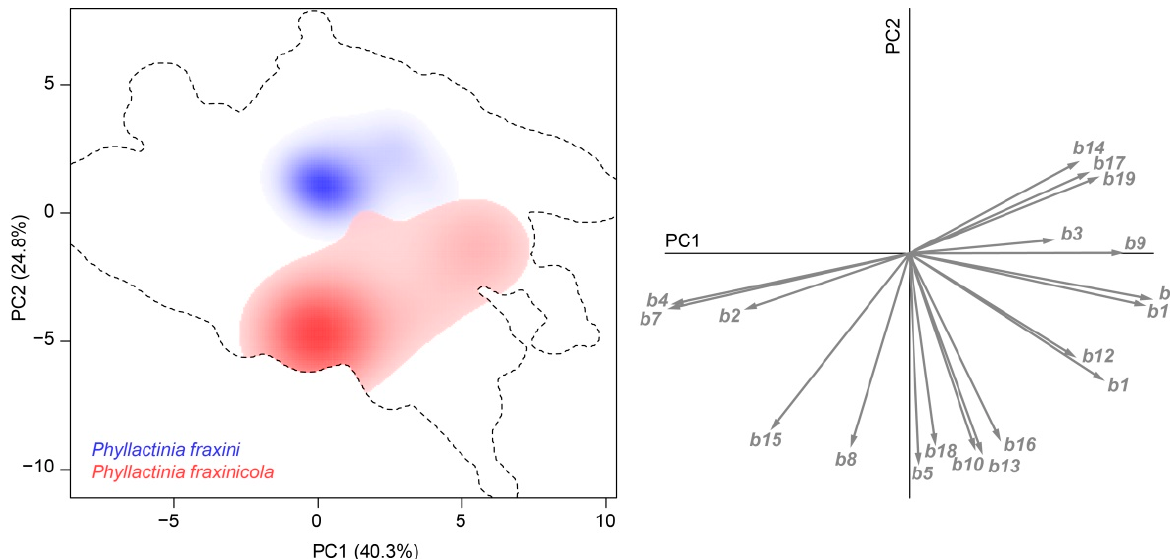
Figure 4. Differences in P. fraxini (blue) and P. fraxinicola (red) environmental niches in principal component space based on bioclimatic variables. Shading is proportional to the density of species occurrence. A dashed line indicates the available environmental space. Vectors of the bioclimatic variables show their contribution to the principal components. Variance explained by the components is given in parentheses. The variable abbreviations are explained in Table